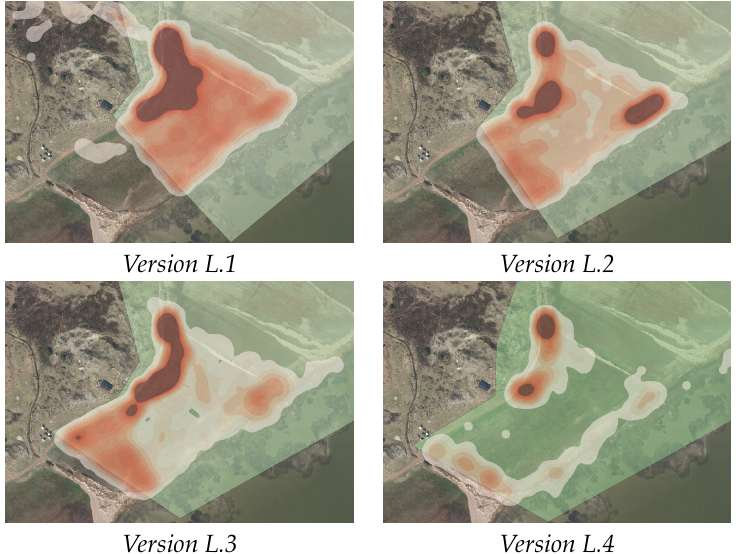
Figure A5. Heatmaps showing the cows’ distribution within the different versions of the virtual enclosure during the learning period. The light green area represents the area of the virtual enclosure for each version.